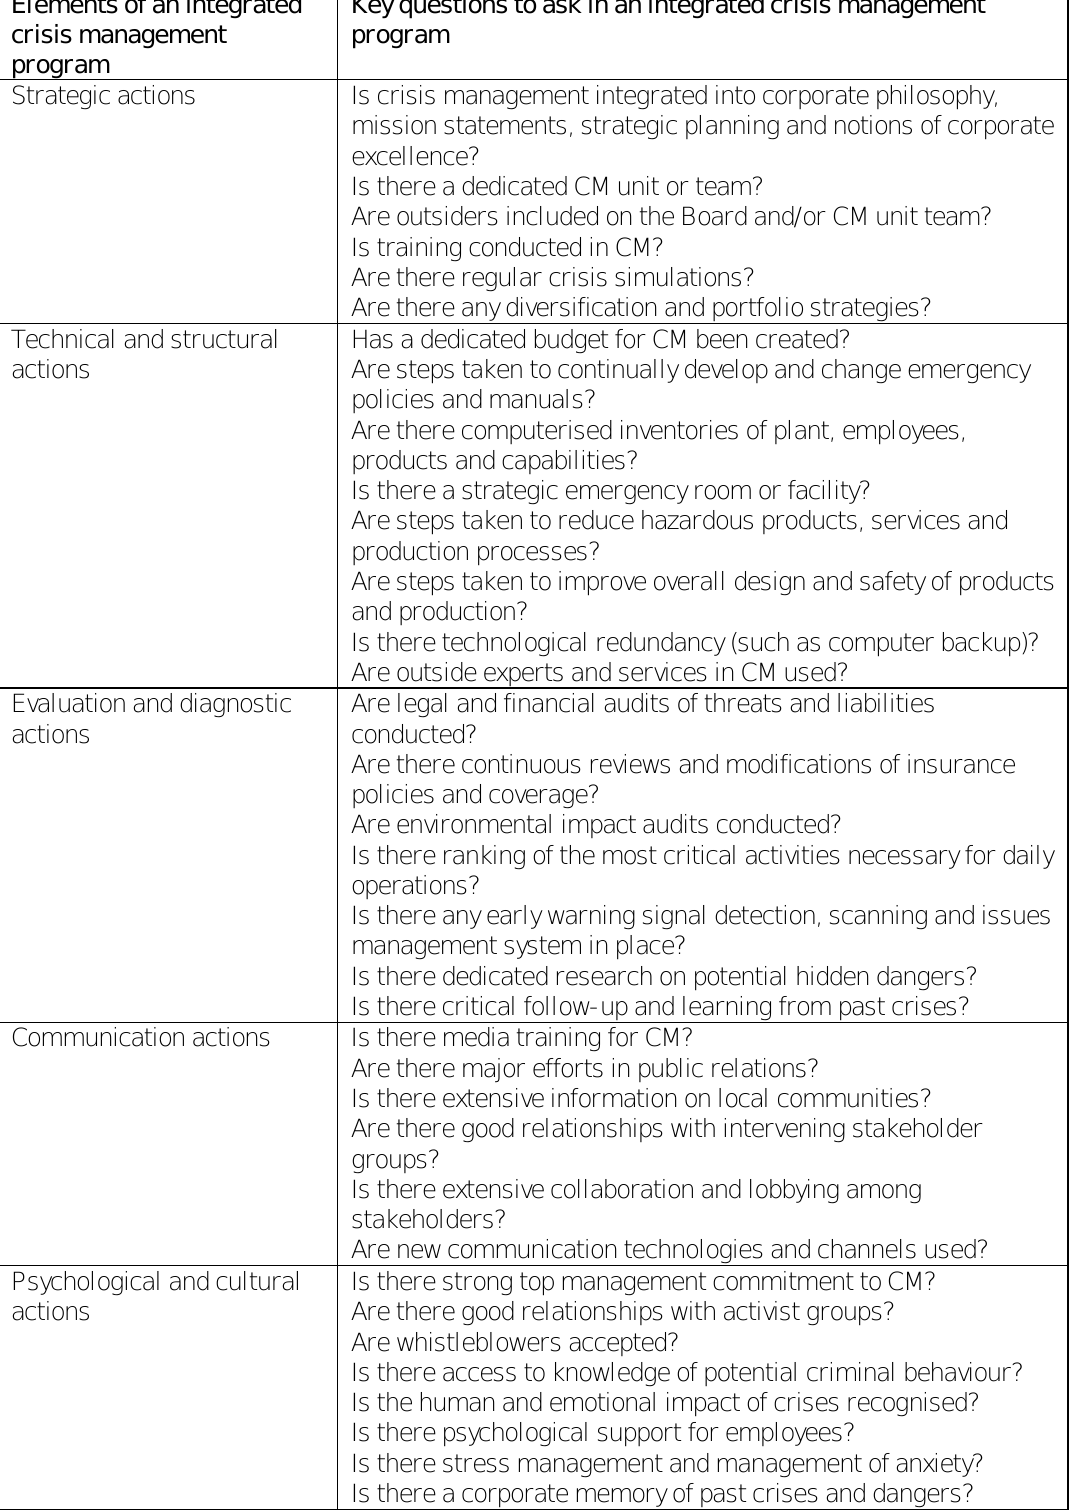
Table 1: Factors in an ideal crisis management (CM) program (Adapted from Mitroff and Pearson 1993,